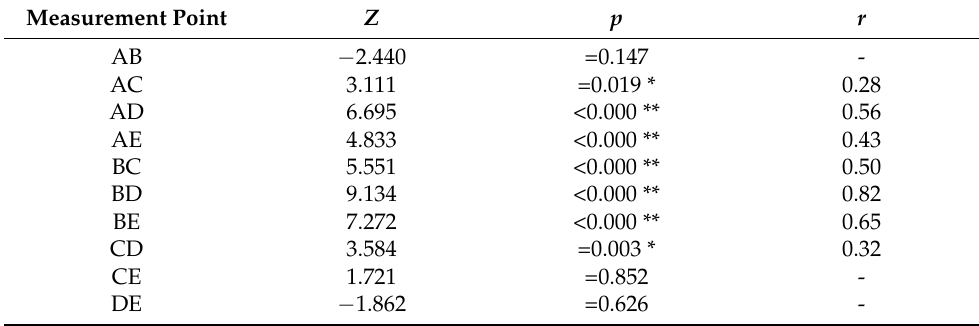
Table A4. Ceramic 4y_DD ( χ 2 (4) = 108.09; p < 0.000); N = 125.